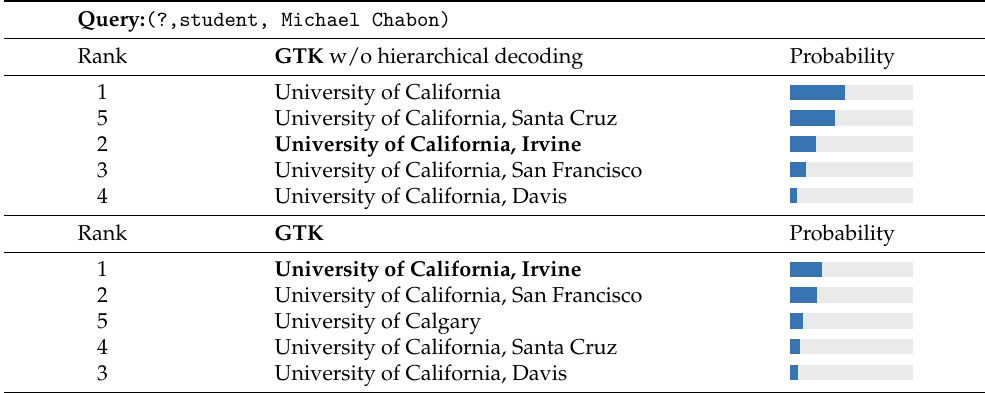
Table 5. We list a query and the first five entities with their probabilities predicted by GTK without entity-aware decoding and the reranking with GTK